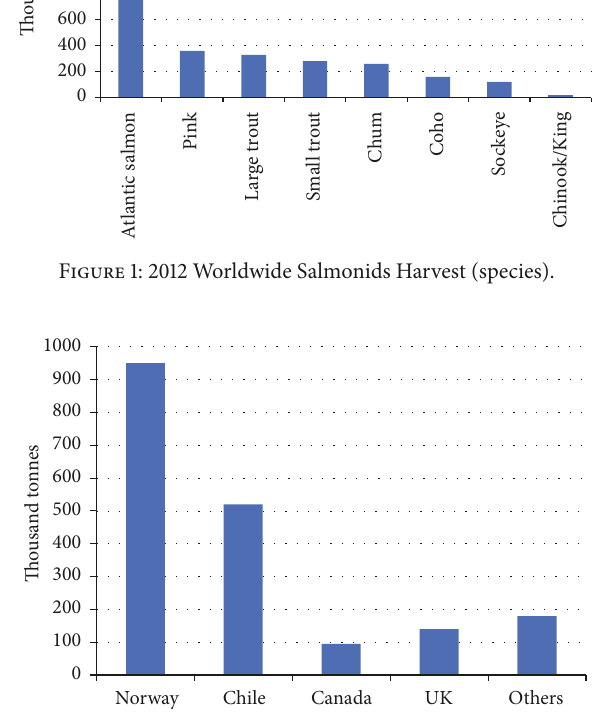
Figure 2: 2011 Worldwide Salmonids Harvest (place of production) (created from